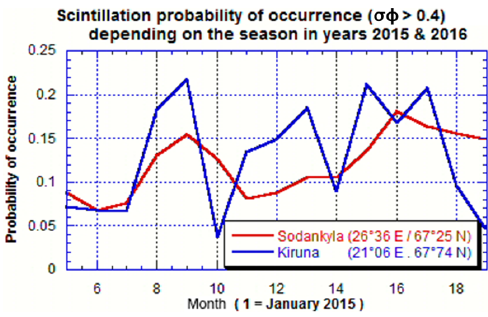
Figure 8. Scintillation seasonal dependency at high latitudes.